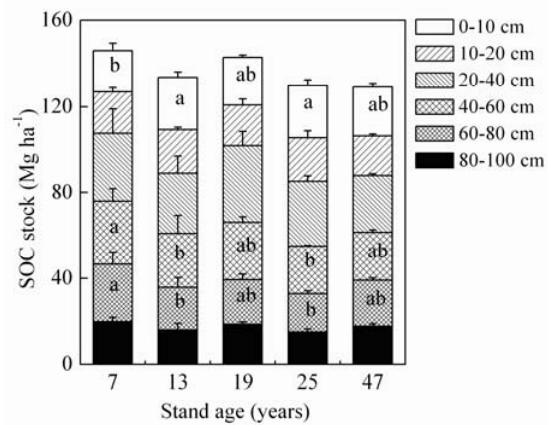
Figure 2. Soil organic carbon (SOC) stock in different soil layers of the 7-, 13-, 19-, 25- and 47-year-old rubber plantations at Xishuangbanna, Yunnan Province, China. Presence of different lowercase letters across a respective soil layer indicates significant differences among means of stand ages according to Tukey’s HSD test ( P < 0.05). Vertical bars show ± S.E.